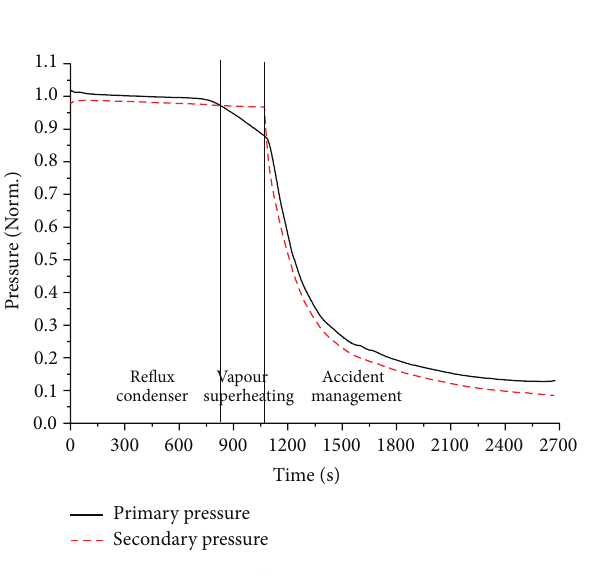
Figure 2: LSTF system pressures. Figure 3: PKL system